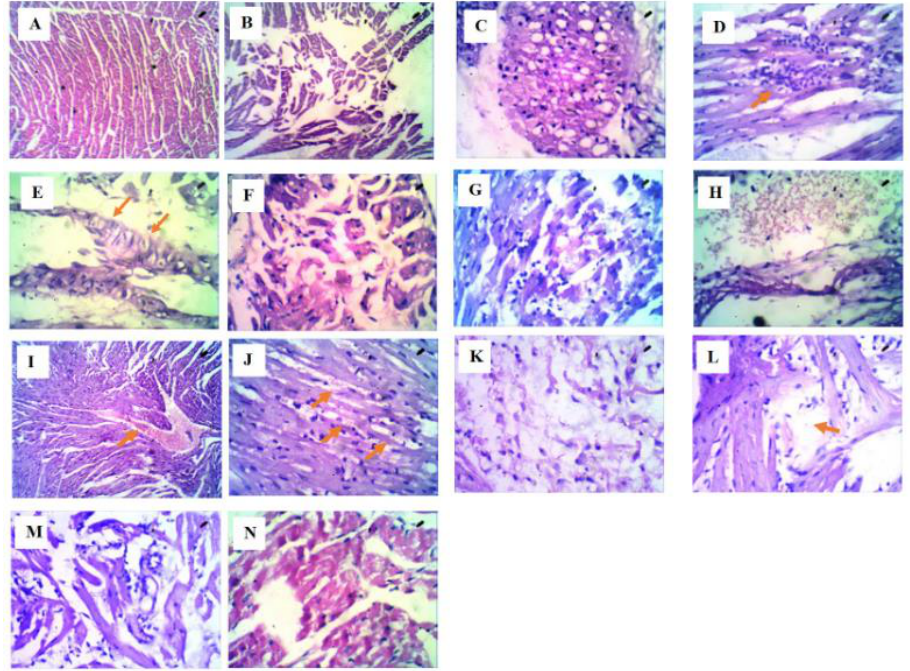
Fig. 1. Histological examinations of heart tissues. A: Control 7 days (normal myocardial smooth muscle fibers); B: Irradiated 7 days (separation of muscle fibers); C: Muscle fibers showing cytoplasmic vacuolization; D: The stroma shows focal lymphocytic infiltrate (arrow); E: Thick walled blood vessels showing vacuolated endothelial cells (arrows); F: Atrophic muscle fibers; G: Muscle fibers showing nuclear internalization; H: Dilated congested blood vessels within the stroma; I: Myocardial tissue showing the area of hemorrhage (arrow); J: Myocardial tissue showing extravasated RBCs (arrows); K: Ectoine plus irradiation 7 days (the stroma shows focal edema and lymphocytic infiltrate); L: Ectoine 14 days (focal interstitial edema (arrow); M: Ectoine 14 days (mild lymphocytic infiltrate indicated by the arrow); N: Ectoine 7 days (muscle fibers showing focal hyaline degeneration indicated by the arrow). (H&EX100-400).